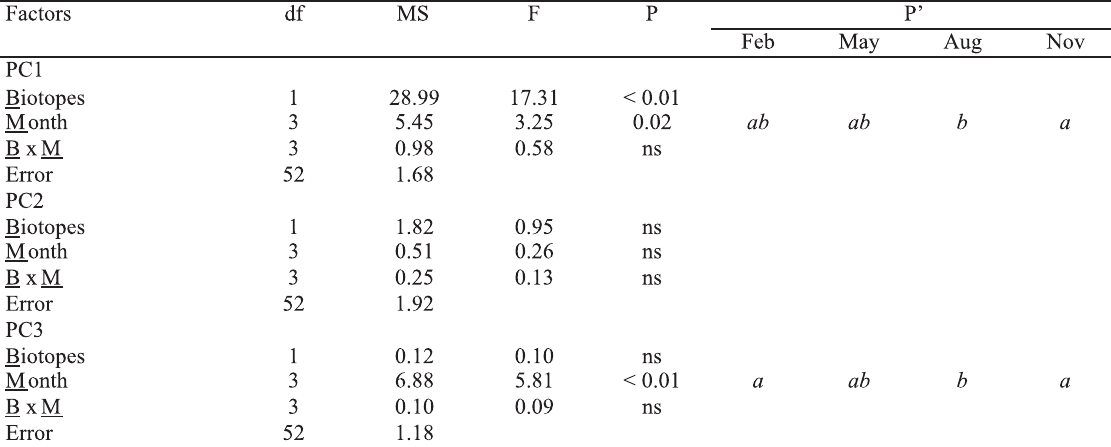
Table 3. Results of two-way ANOVAs applied to PCA scores. Letters ( a and b ) identify averages that differed significantly between months according to Tukey’s Test